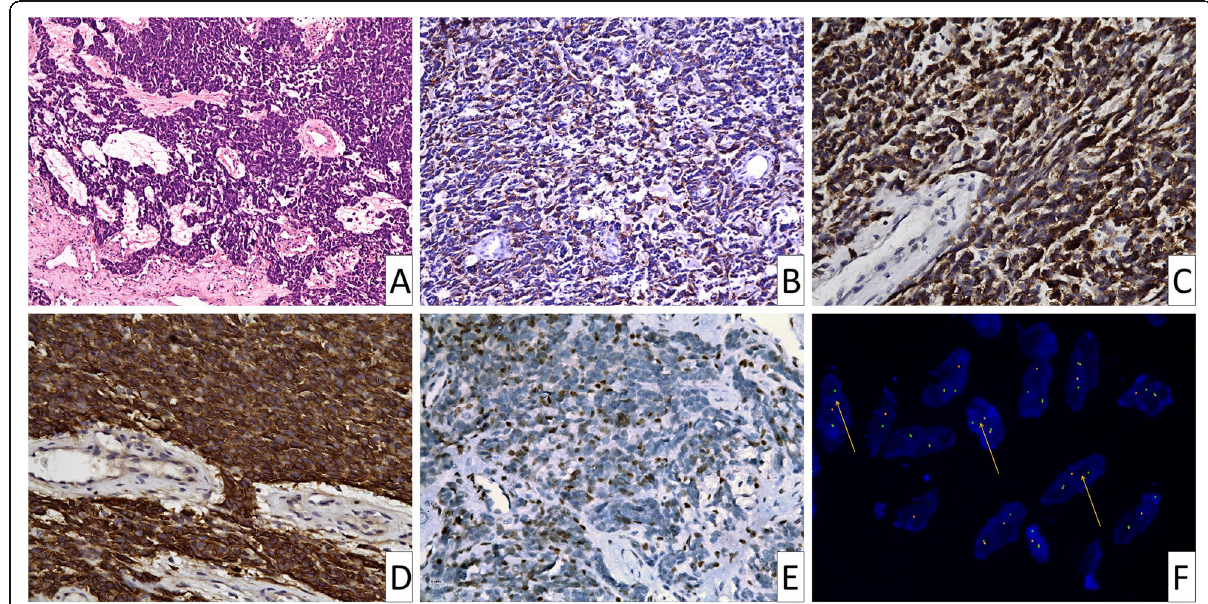
Fig. 4 Microscopic pictures from tracheal mass shows a tumor composed of monomorphic small round cells arranged in sheets ( a ; H&E, 100×), tumor shows immunopositivity for epithelial membrane antigen (EMA) ( b ; 100×), bcl2 ( c ; 200×), MIC2 ( d ; 200×), and TLE1 ( e ; 100×). Interphase fluorescent in-situ hybridization for translocation (X;18) (SYT Vysis break-apart probe) shows a separation of the 5 ′ and 3 ′ SYT signals in many of the tumor cell nuclei (arrows)